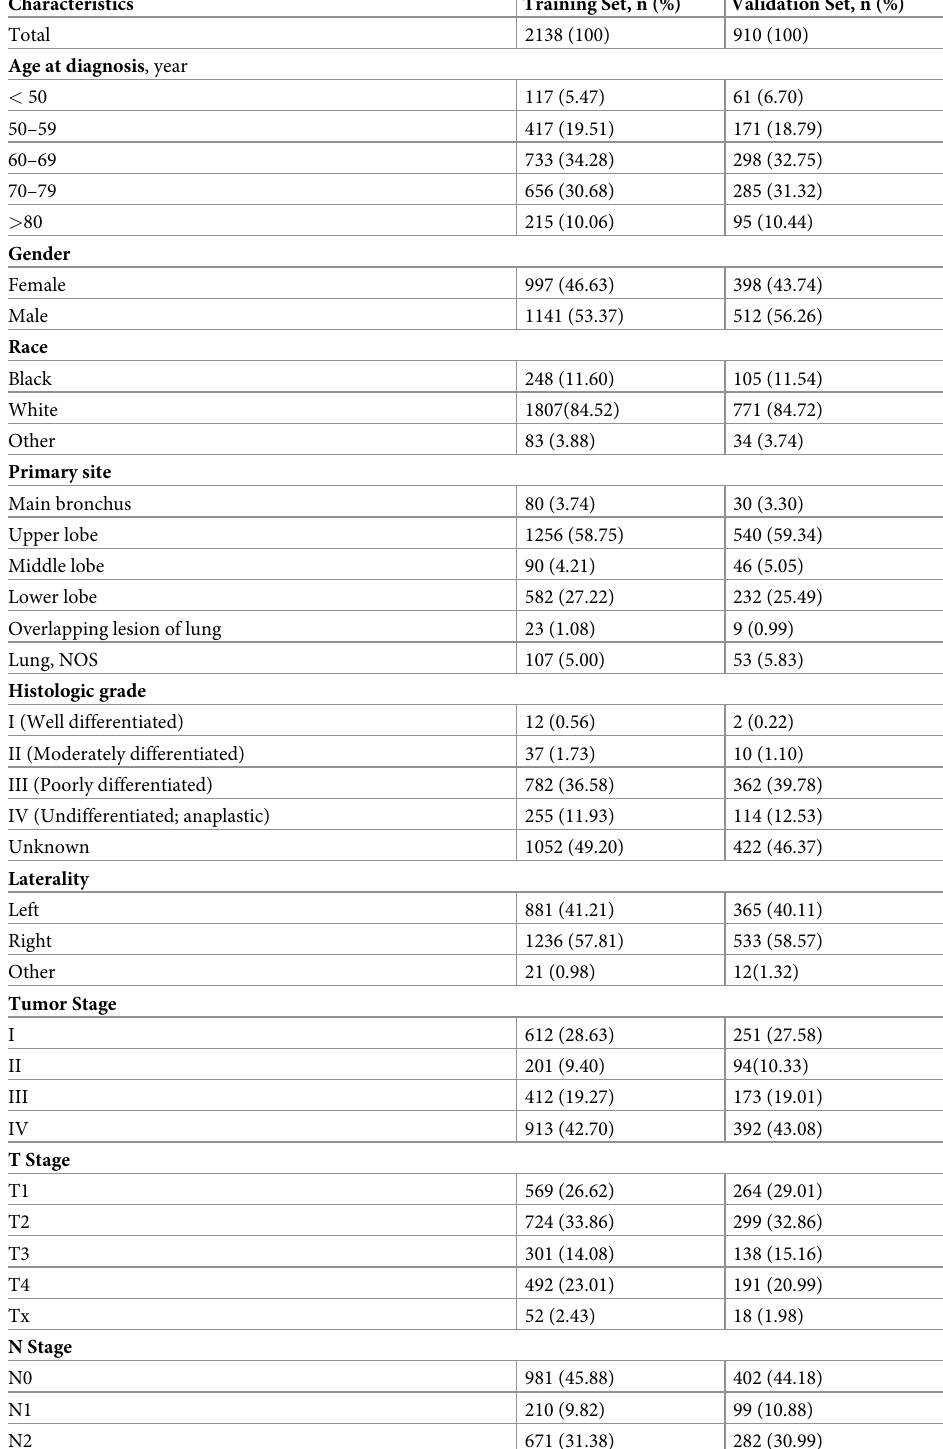
Table 1. Demographic, clinical and pathologic characteristics of patients with large cell neuroendocrine carci- noma (LCNEC) of the lung from the SEER 18 database, 2004–2015 ( n =